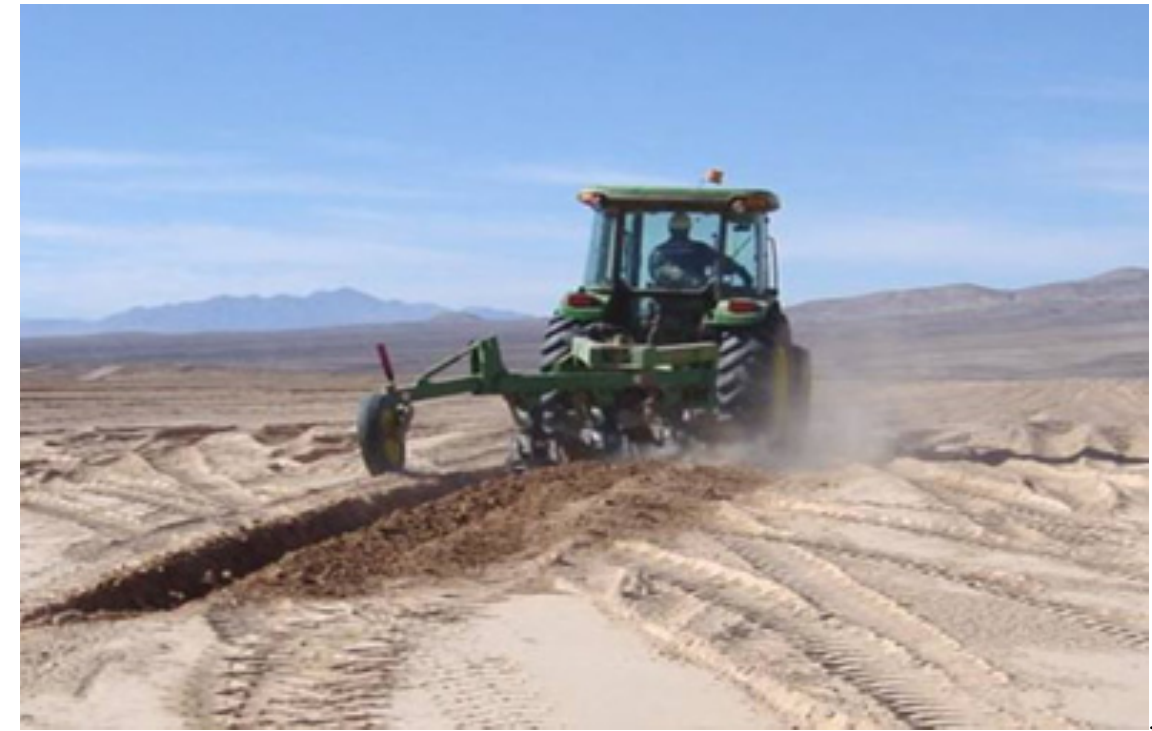
Figure 33. El Peñon Filtered Tailings Storage Facility–Tailings are removed by a disc plow [62,63].